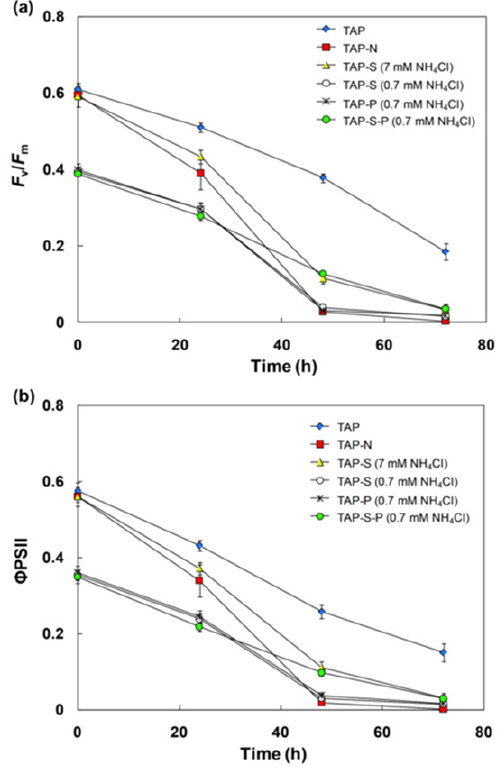
Fig. 3. Change in chlorophyll content (a) and cell numbers (b) of C. sorokiniana during the incubation of synchronized cells in TAP, TAP-N, TAP-S (7 mM NH TAP-S (0.7 mM NH Cl), TAP-P (0.7 mM NH 4 (0.7 mM NH Cl) media. 4